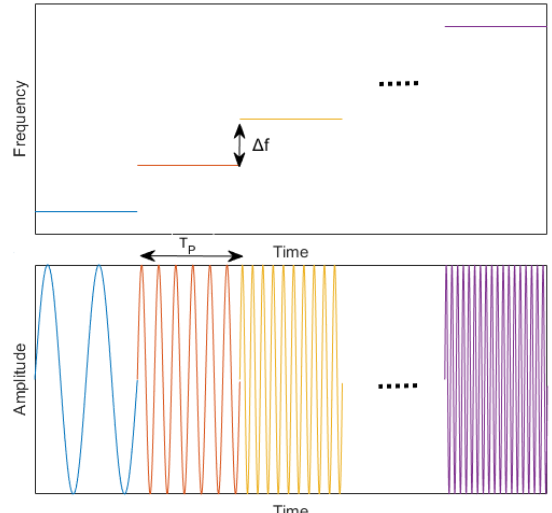
Figure 1: SFCW Radar waveform